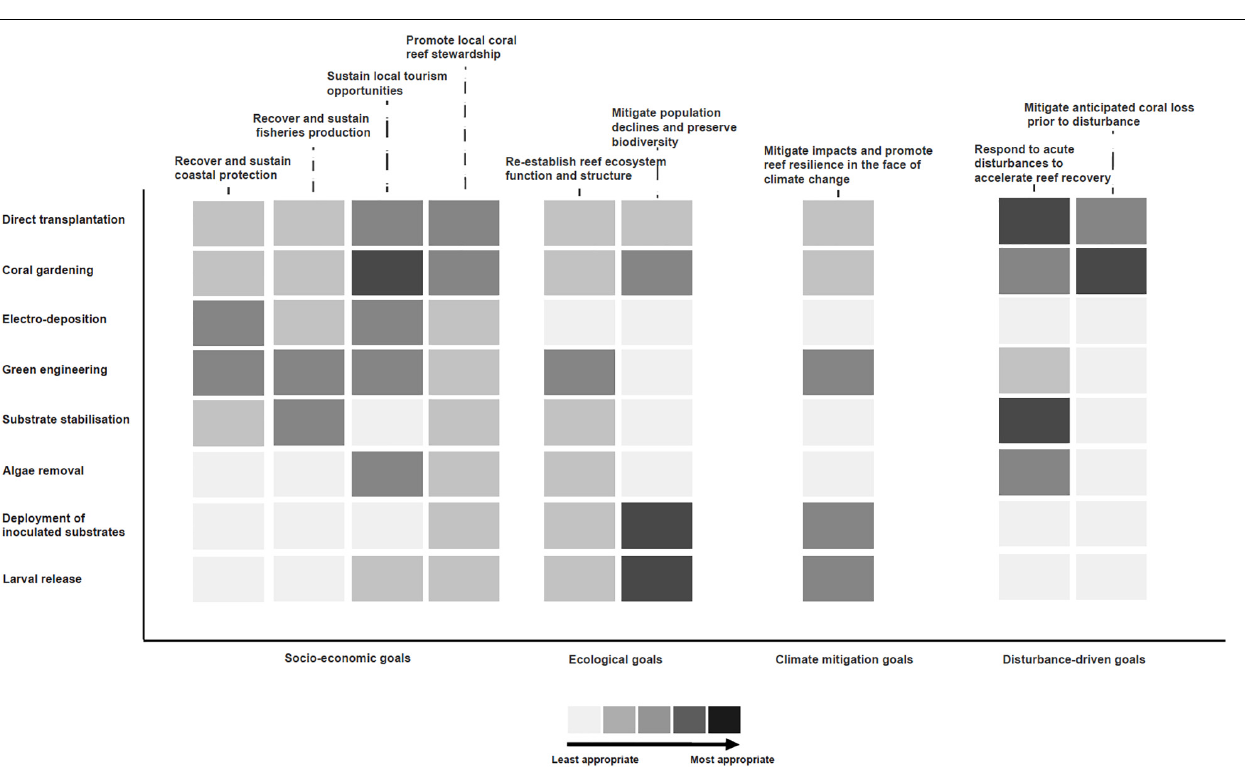
FIGURE 2 | Method suitability matrix for each coral reef restoration goals. The darker the color, the more appropriate a method is to each specific goal. Note that for many goals multiple methods may be